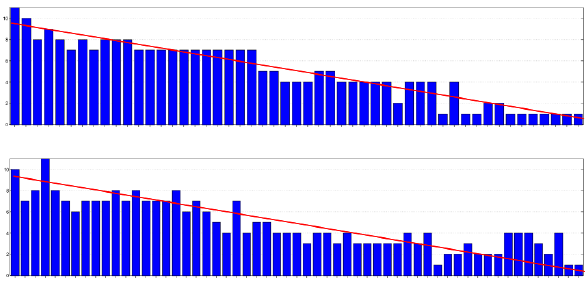
Figure 10: Two highest-frequency patterns of different quality due to depth-of-field influence.